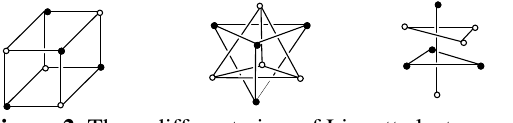
Figure 2. Three different view of Linnett electron arrangement.